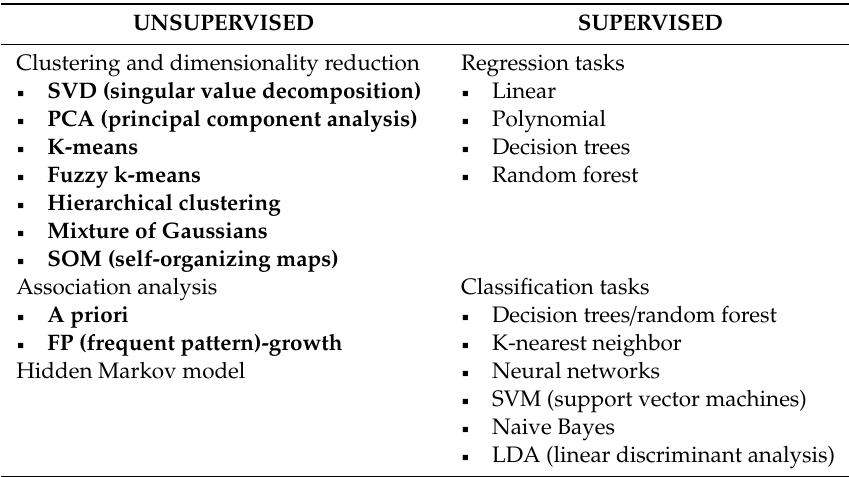
Table 1. Simplified presentation of the possible use of di ff erent machine learning algorithms (also based on already existing and well-established statistical models) * .